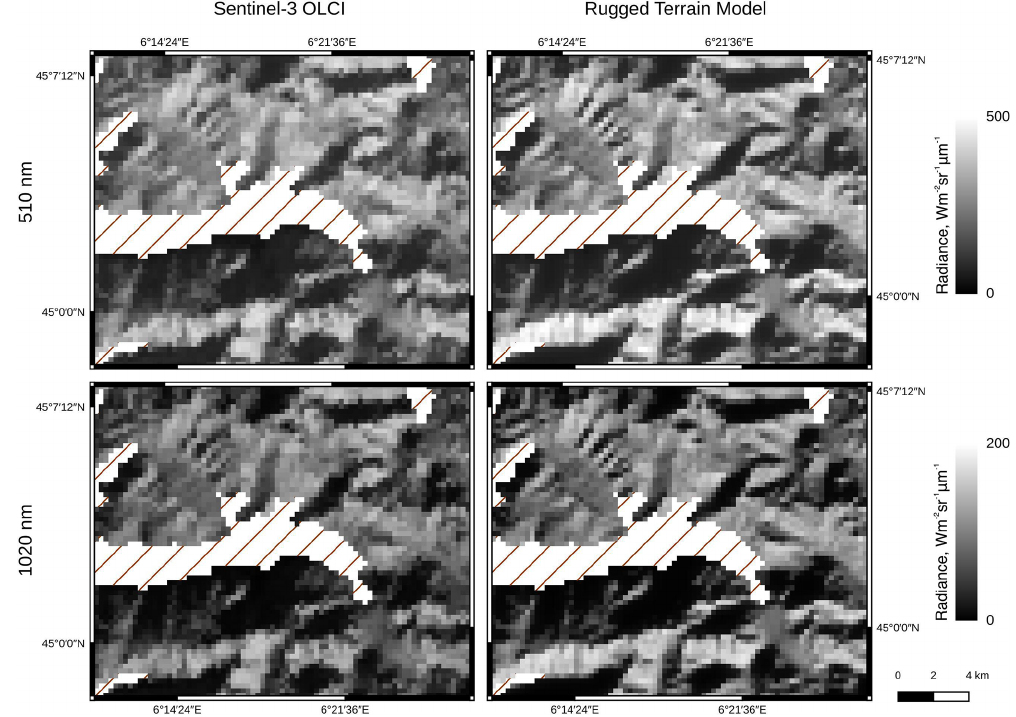
Figure 4. TOA radiance image observed by Sentinel-3 OLCI L1B (©Copernicus) acquired on 13 February 2018 (left) and simulated with the rugged-terrain model (right) at 510nm (top) and 1020nm (bottom). Pixels containing less than 80% of snow were masked out (hatched